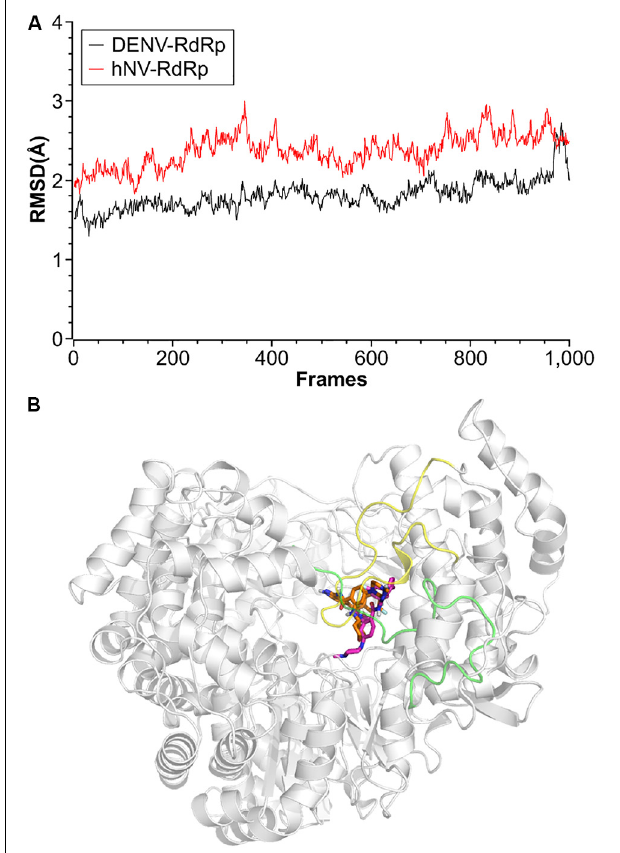
FIGURE 6 | BLI measurement of the interaction between RAI-13 and hNV RdRp (A) or DENV RdRp (B) . Biotinylated hNV or DENV RdRp was immobilized on SSA biosensors and incubated with 2-fold serially diluted RAI-13 (from 3.91 to 125 µ M). Double reference subtraction method was processed to subtract the effect of baseline drift and non-specific binding. KD acquired from fitting into 1:1 binding model by global fitting of multiple kinetic traces and analyzed by Data Analysis 9.0 software. Data shown are representative of three independent experiments.